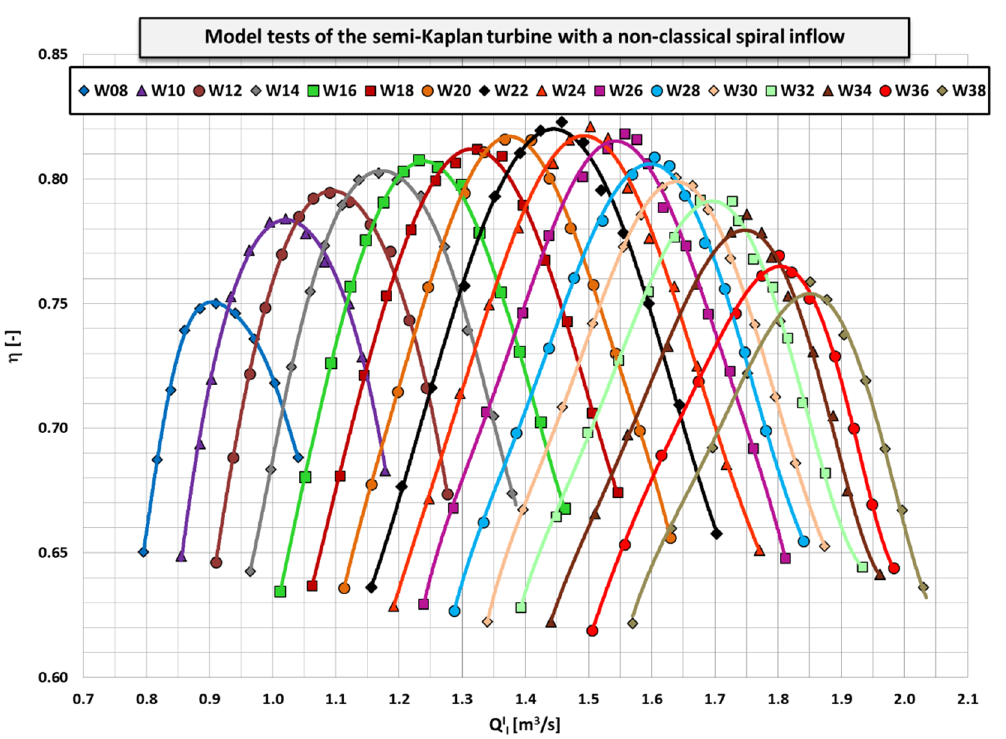
Figure 14. Efficiency curves of the semi-Kaplan model turbine as a function of the double-reduced volumetric flow rate for the openings of the runner blades from 8° to 38° (in 2° steps).